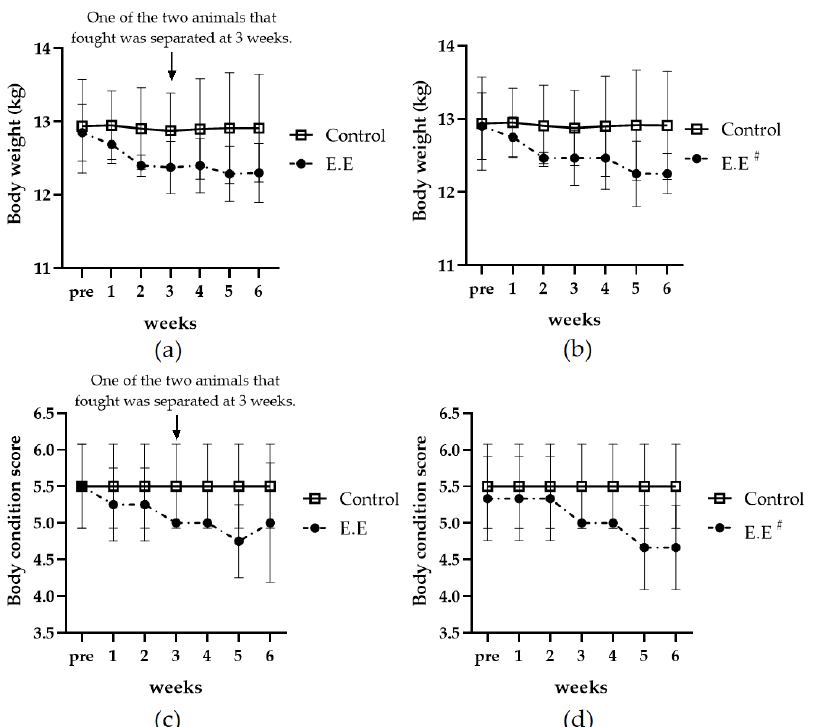
Figure 2. Change in body weights and body condition score (BCSs) at 1-week intervals, including before the environmental change of placing them into the cages (pre) for a total of 6 weeks. Change in body weight when the separated fighting dog was ( a ) included and ( b ) not included. Change in body condition scores when the separated fighting dog was ( c ) included and ( d ) not included. E.E: Environmental enrichment group. # Except for the one dog that fought.